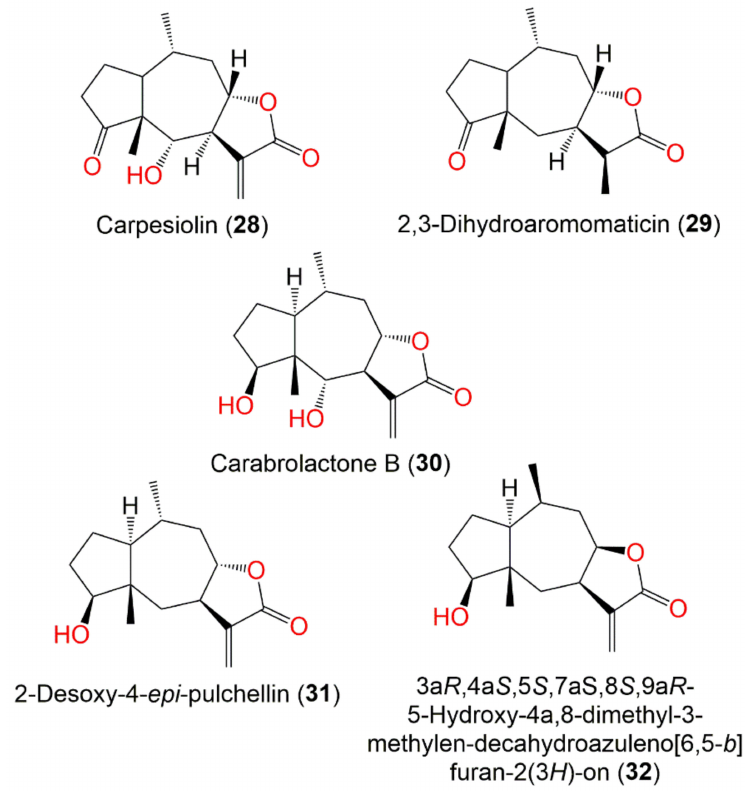
Figure 6. Pseudo-guaianolide sesquiterpenes ( 28 – 32 ) reported from C. abrotanoides